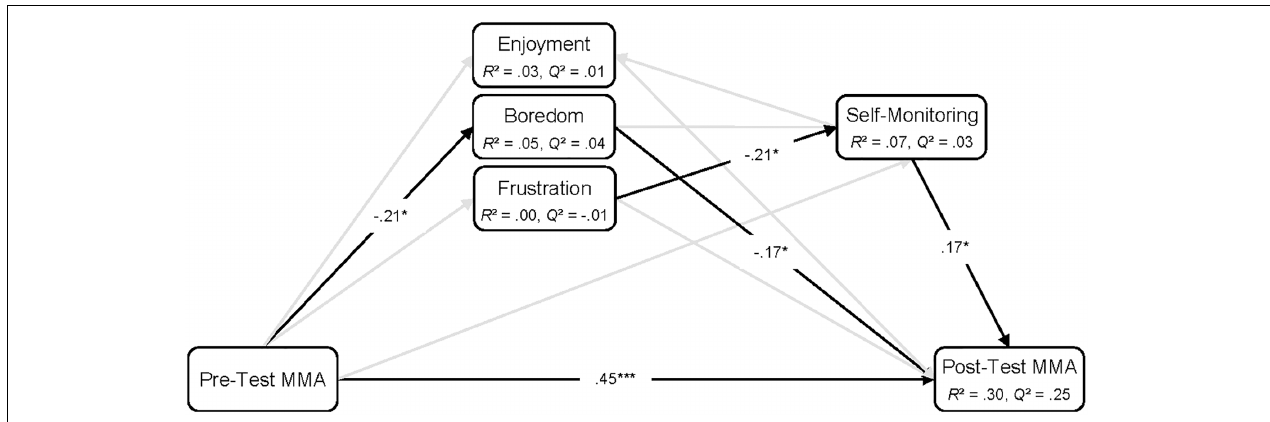
FIGURE 7 | PLS-PM path model analysis showing paths between aggregated enjoyment, boredom, frustration, and self-monitoring, as well as pre-, and post-test MMA. MMA, mental model accuracy. Black lines, significant paths; gray lines, non-significant paths. n = 108. ∗ p < 0.05, ∗∗ p < 0.01, ∗∗∗ p < 0.001.